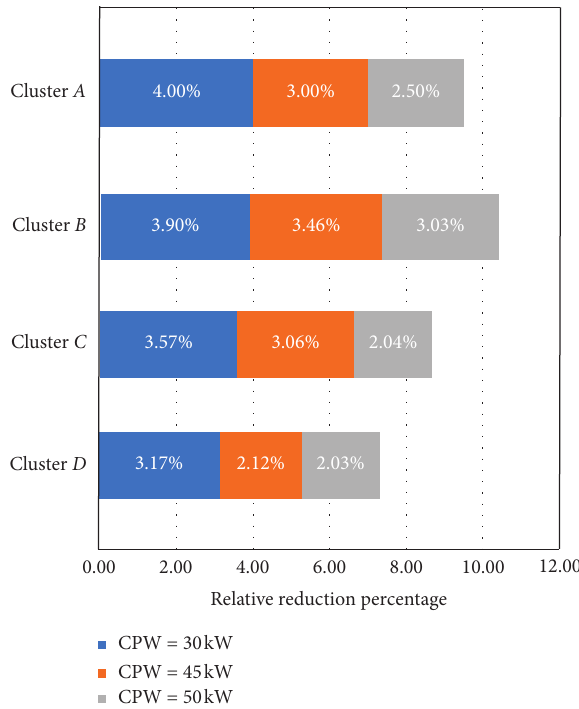
Figure 7: A stacked bar chart of relative reduction